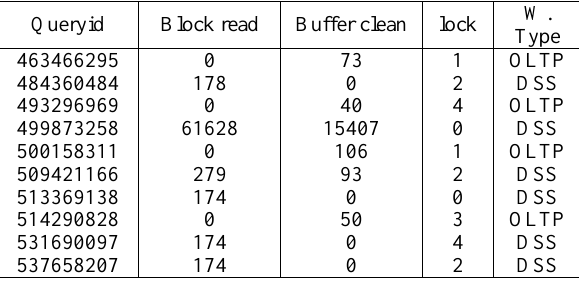
Table 1. Floating-point operations to classify a